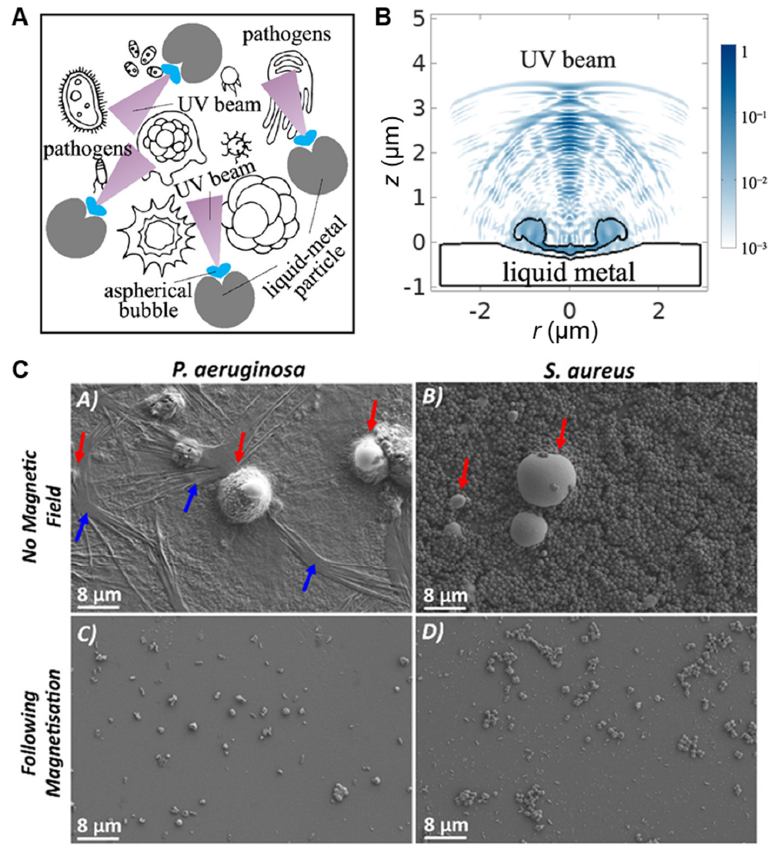
Figure 8. ( A ) Collapse of air bubbles in water near LMNPs for generating UV irradiation to kill pathogens. ( B ) Simulation results showing light emitted by an aspherical bubble near the liquid-metal surface. Reproduced with permission from NPG [60]. ( C ) SEM visualization of the P. aeruginosa and S. aureus biofilms following 24 h of growth with LMNPs (indicated by red arrows). Biofilms of these two bacteria groups and the self-produced extracellular polymeric substances are indicated with blue arrows. Applying an external rotating magnetic field for 90 min successfully removed the biofilms. Reproduced with permission from ACS